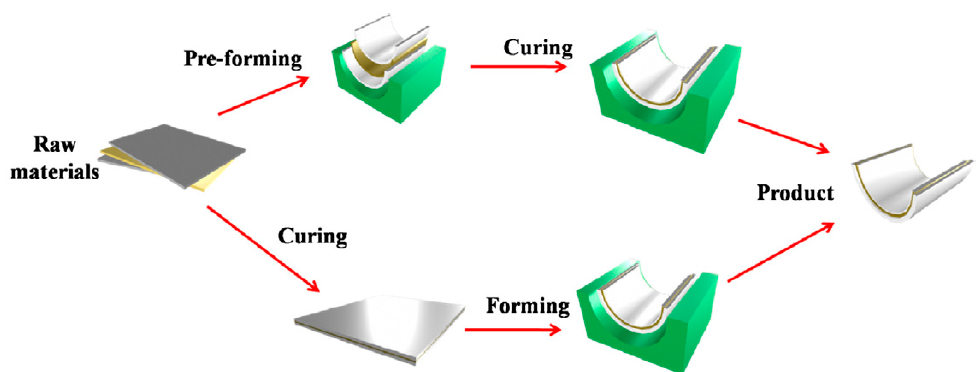
Figure 30. The routes to create a HMPC (reproduced with permission from [230]; copyright© 2021 Elsevier Ltd.). Table 4. Main advantages and disadvantages of selected methods of fabricating HMPC compo ‐ nents.